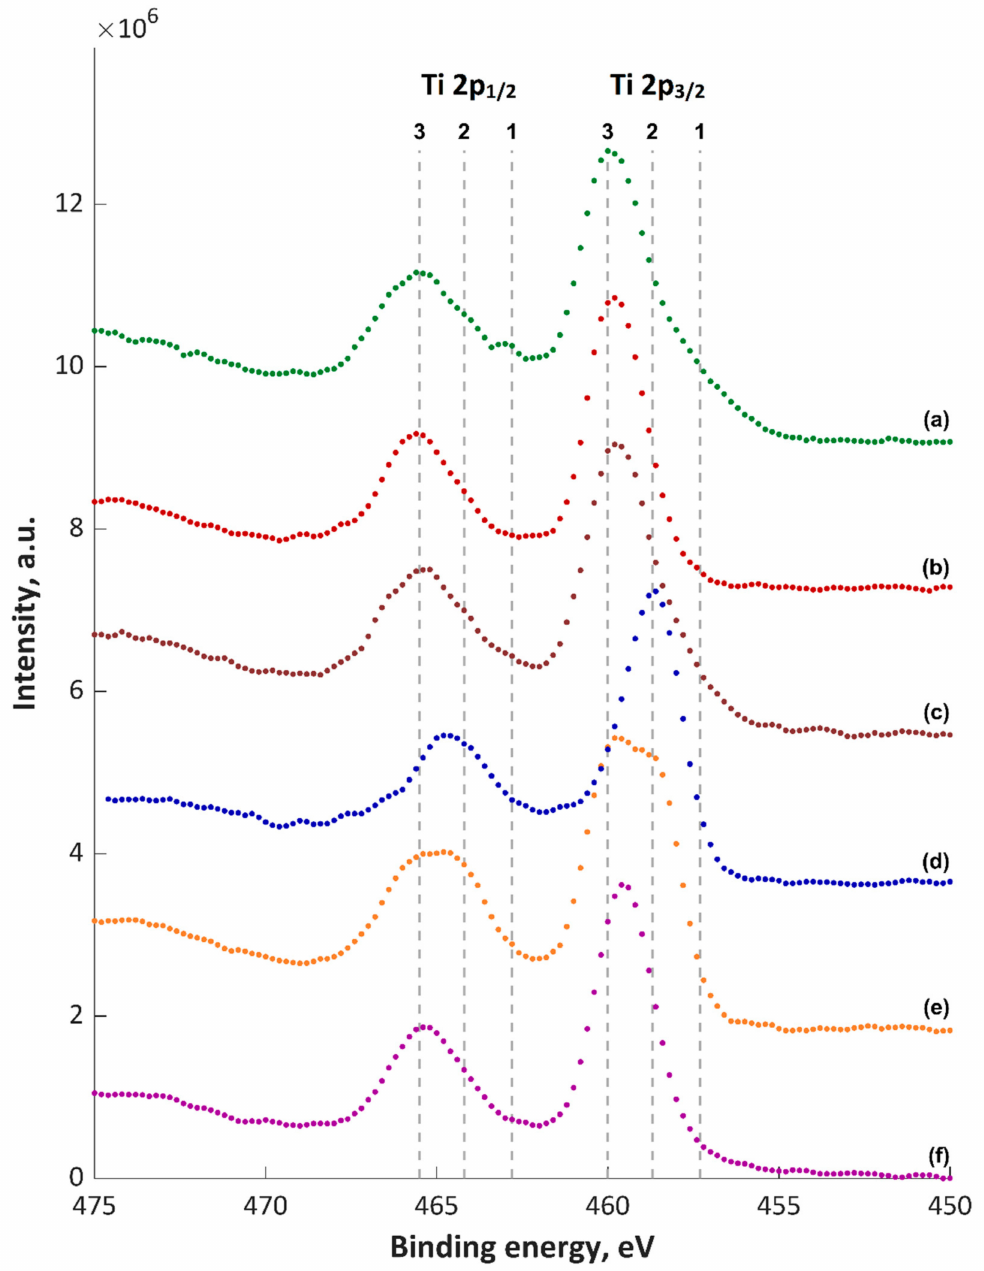
Figure 5. XPS Ti2p spectra of PEO coatings: ( a ) TiZnCu-35; ( b ) TiZnCu-135; ( c ) TiZnCuCa-35; ( d ) TiZnCuCa-135; ( e ) TiZnCuMg-35; and ( f ) TiZnCuMg-135; 1, Ti 2 O 3 ; 2, 3, TiO 2 , CaTiO 3 and / or Ti 3 (PO 4 ) 4